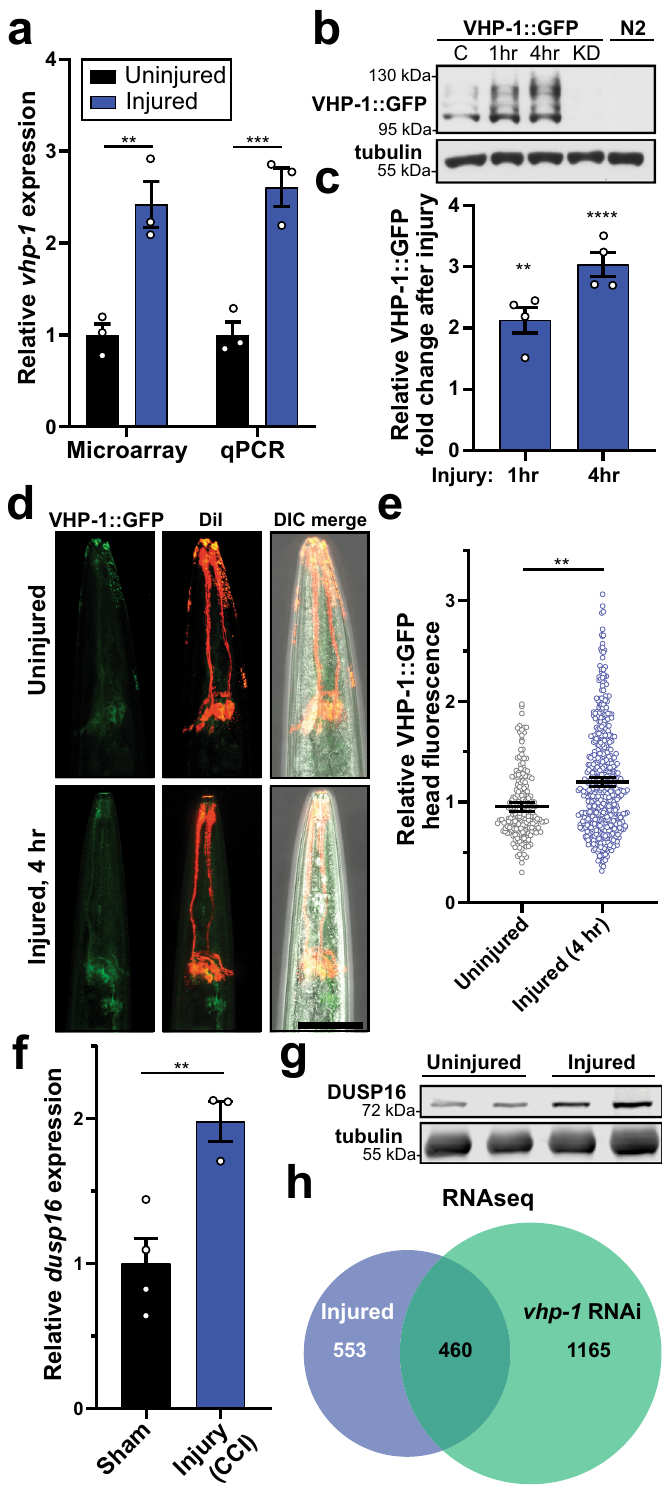
in total brain tissue two hours post trauma in our mouse model of closed-head concussive injury (Fig. 4g), suggesting shared tran- scriptional and translational control in mice or worms subjected to blunt trauma. Interestingly, RNAseq analysis from worms given trauma or treated with vhp-1 RNAi revealed that nearly half (460/1013) of the genes signi fi cantly upregulated by trauma